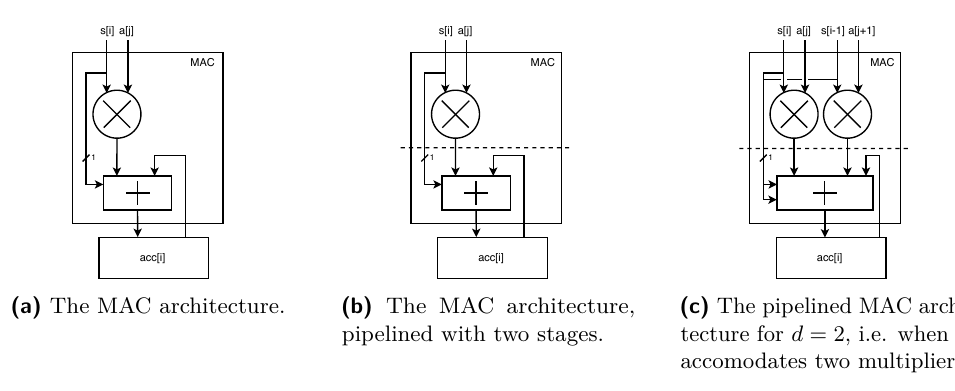
Figure 7: Different architectures of MAC